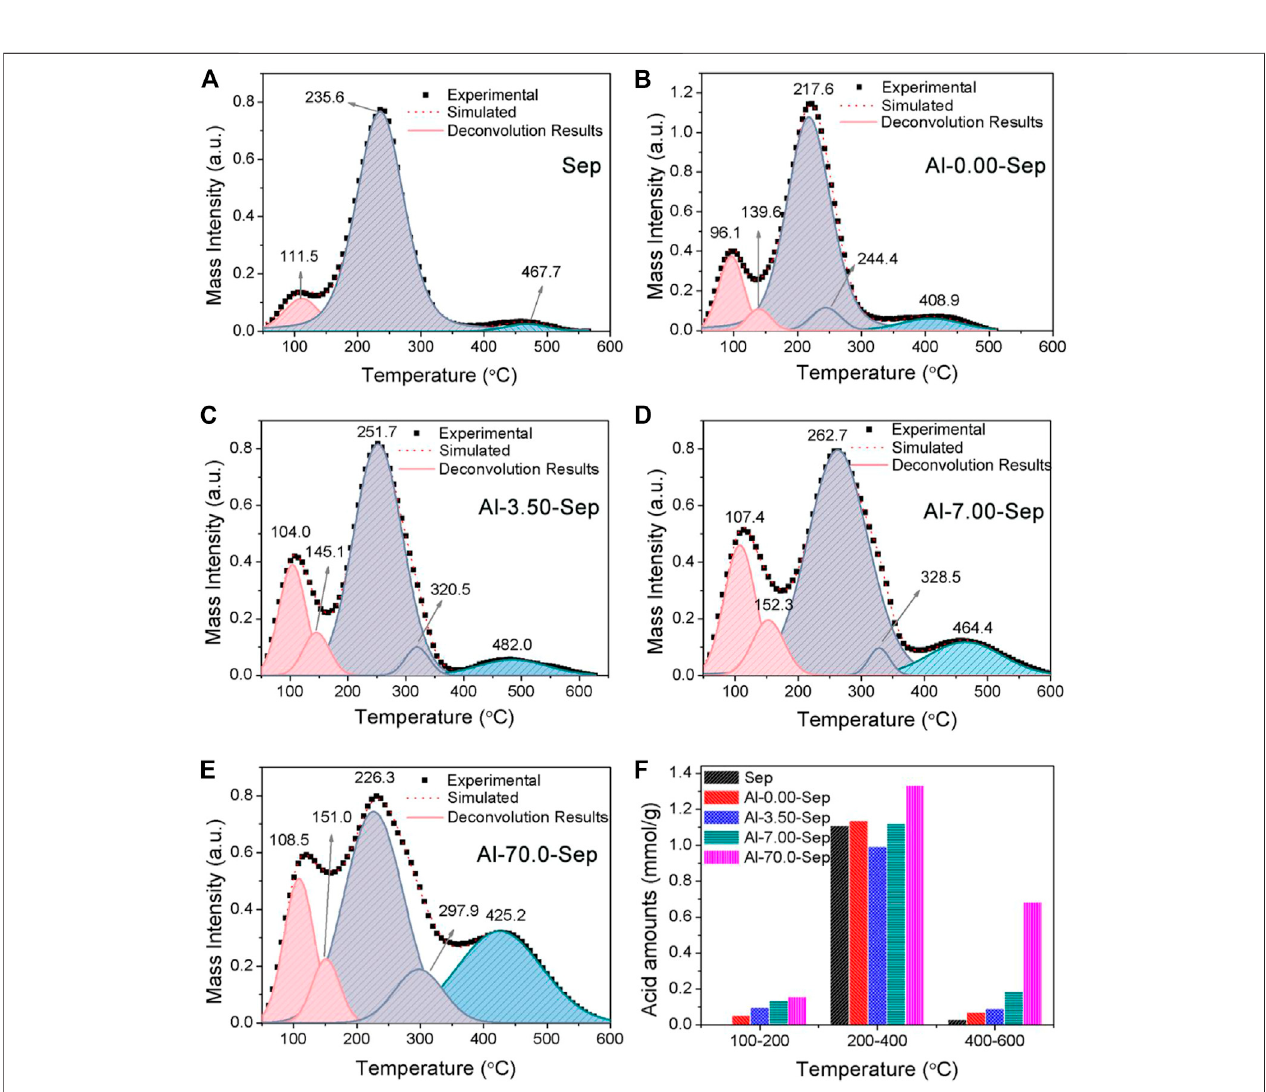
Frontiers in Chemistry |